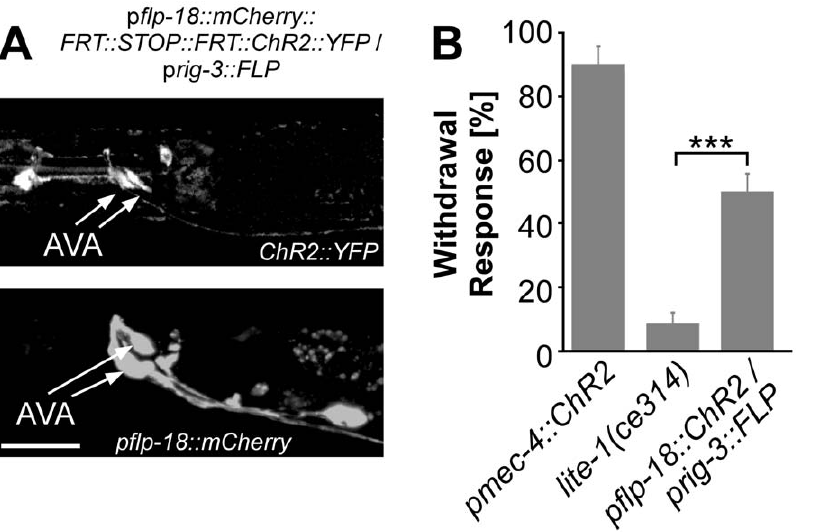
Figure 4. Expression pattern and behavioral responses of animals generated towards ChR2 expression in AVA by using FLP recombinase. A ) Fluorescence images of animals expressing ChR2::YFP by using flp-18 and rig-3 promoter pair with the FLP recombinase (top). Bottom panel shows p flp-18 ::mCherry expression. Scale bar=20 m m B ) Behavioral assay testing withdrawal reactions in response to 470 nm blue light illumination were as described in Fig. 3D (n $ 15). doi:10.1371/journal.pone.0043164.g004 AVA ( Fig. 5A ). The second combination tested (p flp-18 /p rig-3 ) showed an expression of GFP in AVA and also a minor expression in AIY, a pair of neurons which is involved in thermosensation [50]. Finally, the combination of p flp-18 and p gpa-14 showed bright expression of GFP in AVA neurons only ( Fig. 5C ). We carried out behavioral assays to test the reaction of the three Cre- loxP AVA lines to blue light illumination ( Fig. 5D ). As a positive control we used animals expressing ChR2 in touch neurons (p mec- 4 ::ChR2). As a negative control, we used lite-1(ce314) animals expressing no ChR2. 93% of the positive control nematodes showed a backward movement, i.e. full reversal, not just slowing of forward locomotion, during or directly after a 1 s blue light stimulus, while the Cre-loxP lines showed a reaction between 33% and 73%. The highest reaction was observed in the line with the p flp-18 /p gpa-14 promoter pair, i.e. the one with the AVA specific ChR2 expression.